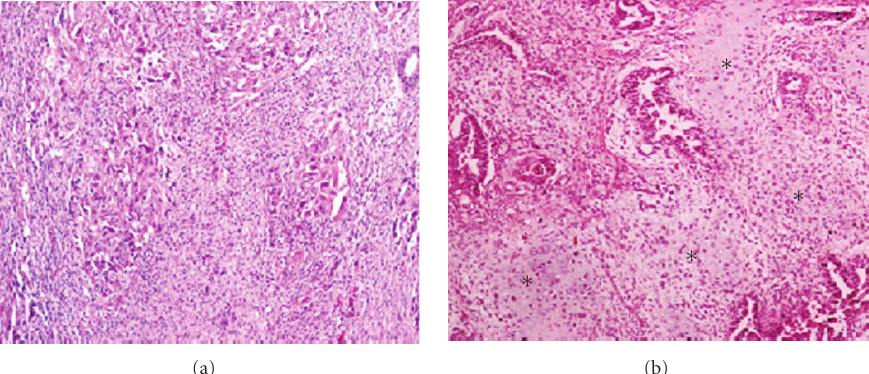
Figure 4: Carcinosarcoma is composed of two malignant components, carcinomatous and sarcomatous. The epithelial component is usually high grade carcinoma for example, serous/clear cell type. The mesenchymal part comprises either homologous (a), × 100 or heterologous element for example, cartilage or bone. Chondrosarcomatous element ( ∗ ) is present in (b), ×